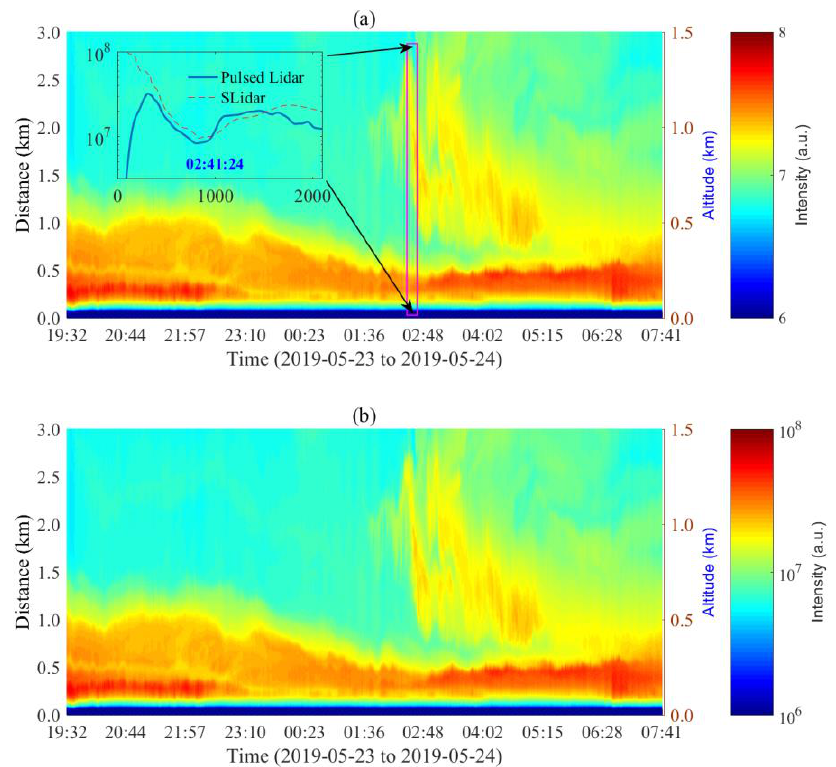
Figure 2. Atmospheric backscattering signals measured by ( a ) the SLidar system and ( b ) the pulsed lidar system in May 2019 (Local time). The elevation angle of the two lidar systems was 30 degrees. The pulsed lidar system has been optimized for the detection of the near range lidar signal.